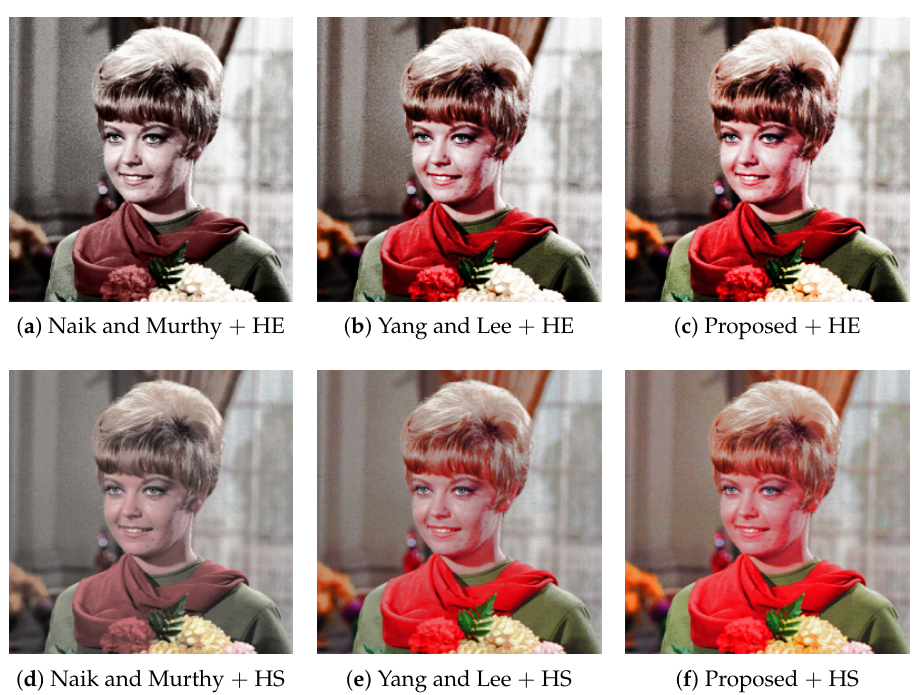
Figure 6. Hue-preserving color image enhancement: The top row ( a – c ) shows the output images with histogram equalization (HE) for computing target intensities, and the bottom row ( d – f ) shows that with histogram specification (HS). The left ( a , d ), middle ( b , e ) and right ( c , f ) columns show the results with Naik and Murthy’s method, Yang and Lee’s method and the proposed methods, respectively.